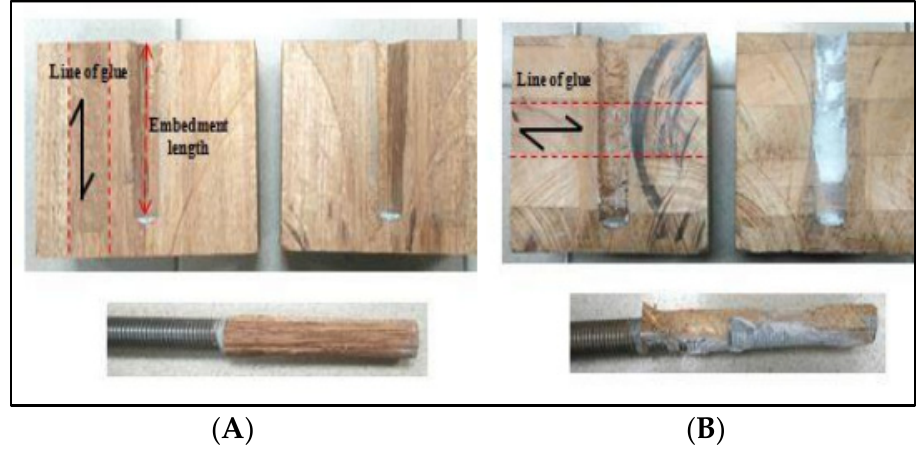
Figure 6. Sample of The Specimens of Glued-In Rod Tested for Both Directions: ( A ) Parallel and ( B ) Perpendicular to The Grain.